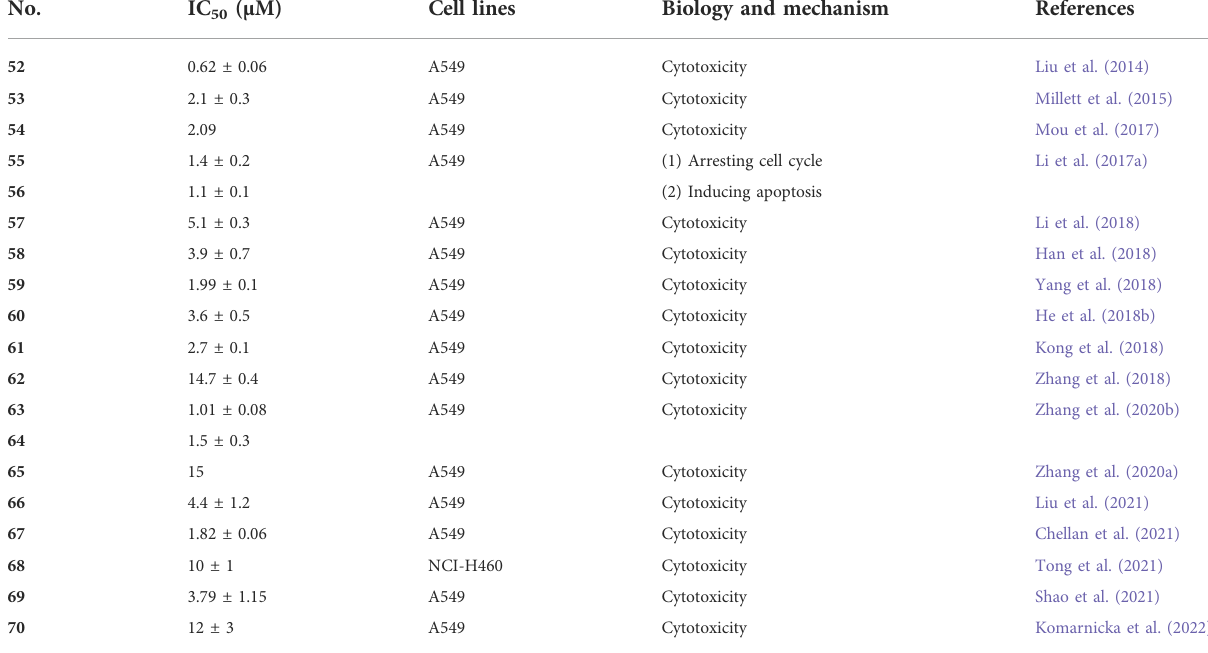
TABLE 2 Organoiridium (III) “ half-sandwich ” complexes as promising candidates against lung cancer.